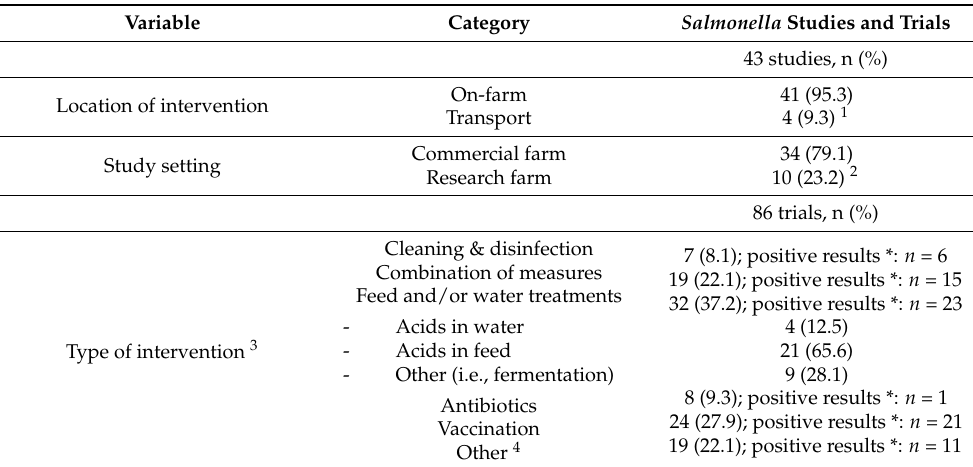
Table 3. Descriptive characteristics of the 86 trials described in the 43 studies investigating pre-harvest interventions to control Salmonella spp. in